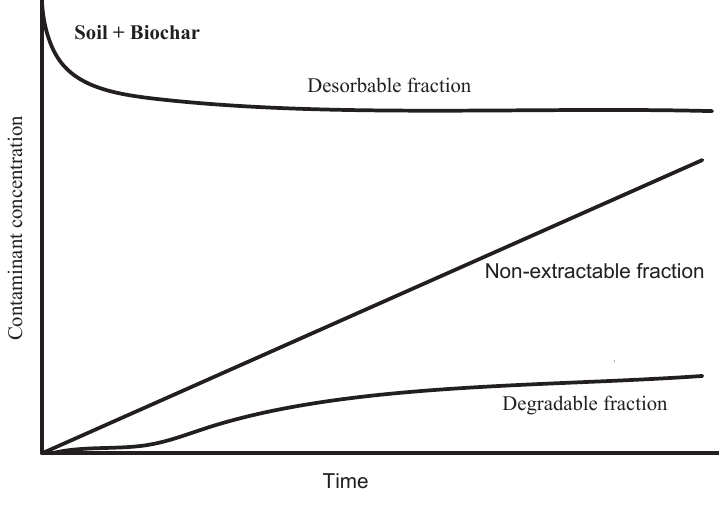
Figure 3. The influence of contact time on the extractability and bioaccessibility of a contaminant in biochar-amended